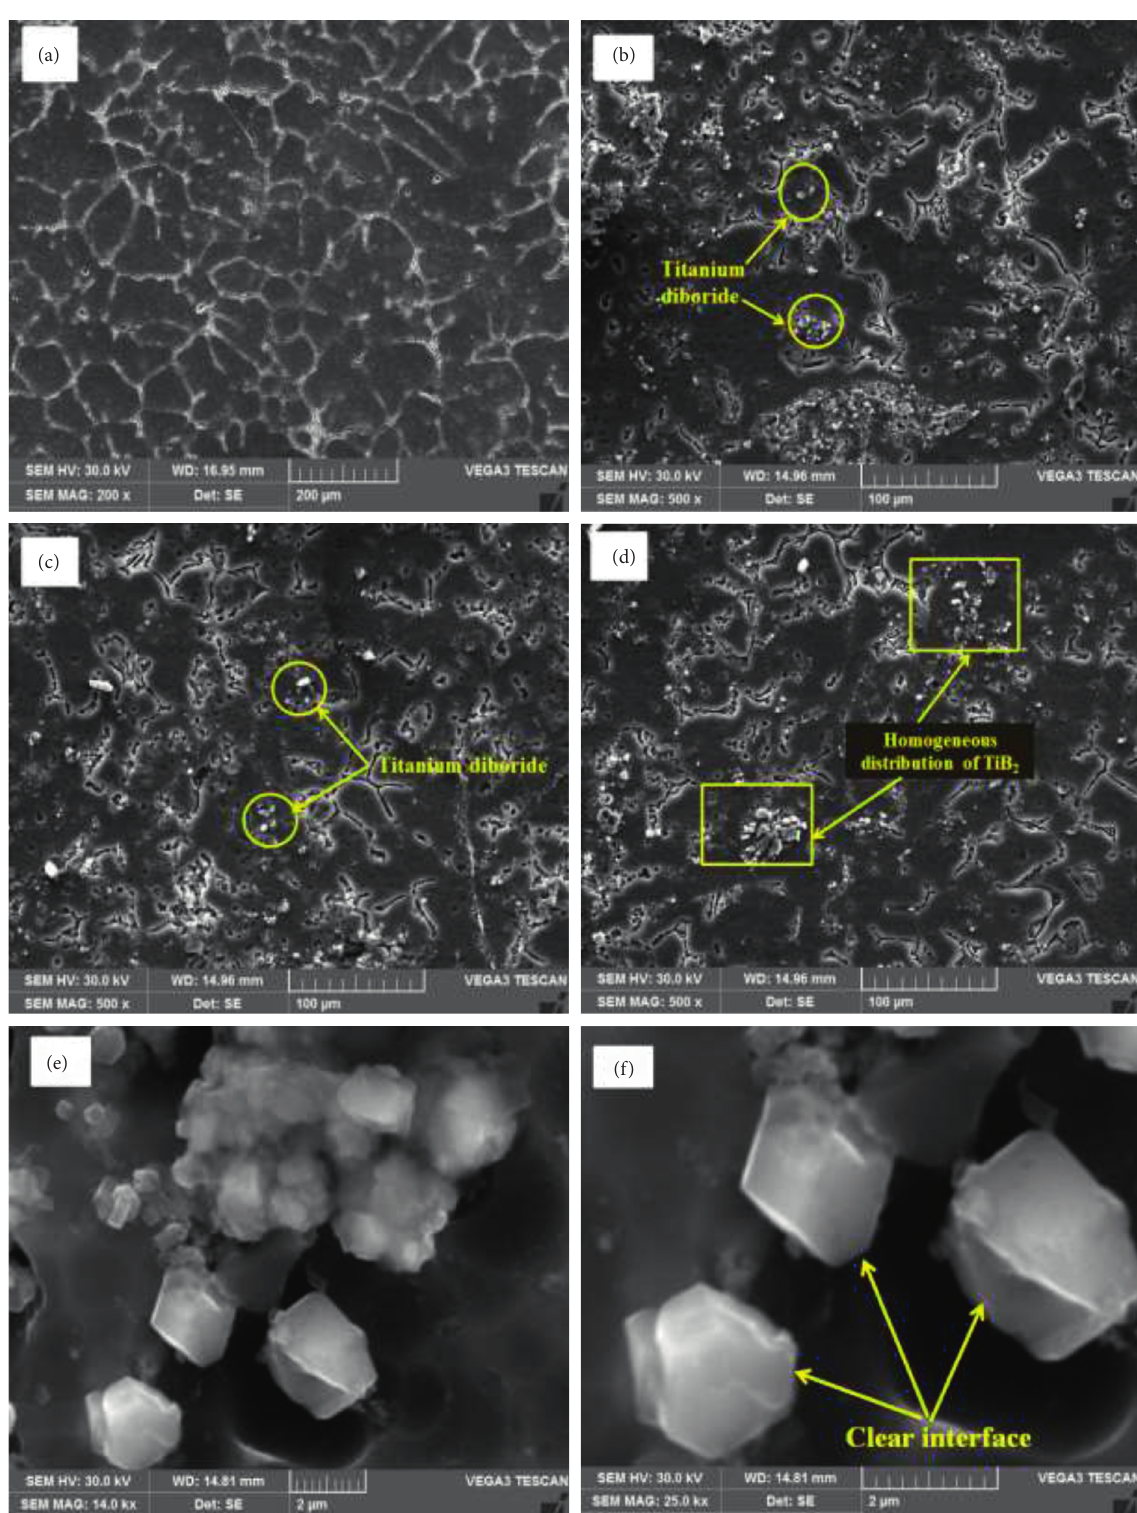
Figure 3: SEM micrographs of AA6082/TiB